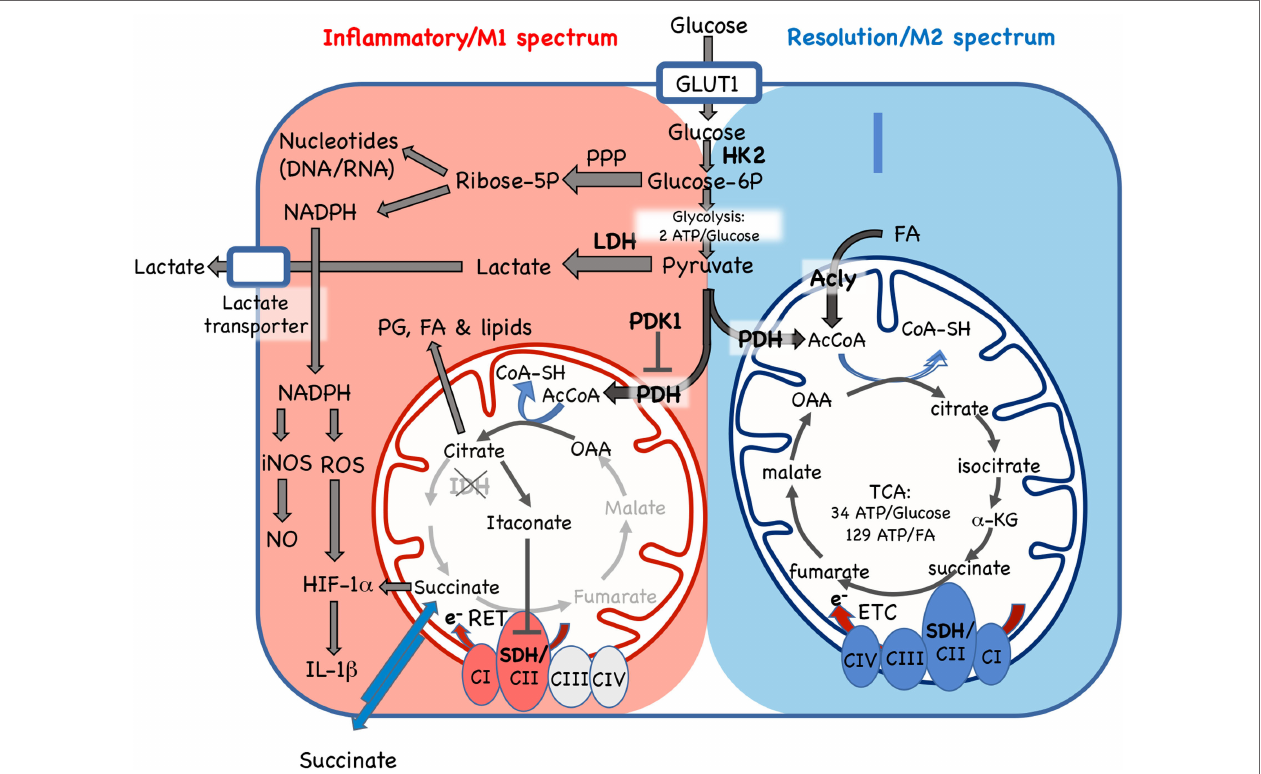
FiGURe 2 | Cellular metabolic pathways driving mononuclear phagocyte inflammatory vs. resolution phenotype. Glucose is essential for both inflammatory and resolution macrophage phenotypes. In inflammatory macrophages, glucose is largely processed to yield lactate via aerobic glycolysis. Another major pathway in M1 spectrum macrophages is conversion to ribose-5P via the pentose phosphate pathway (PPP) for synthesis of nucleotides and NADPH, which supports nitric oxide (NO), reactive oxygen species (ROS), and IL-1 β production. In resolution macrophages, the major fate of glucose is the TCA/Krebs cycle via pyruvate dehydrogenase (PDH)-catalyzed conversion of pyruvate to AcetylCoA (AcCoA). The TCA cycle in resolution macrophages is also fed by fatty acids (FA) via the ATP-citrate lyase (Acly) enzyme and promotes forward electron transport chain (ETC), from C1 to CIV, for ATP generation. In contrast, while some glucose enters the mitochondria in inflammatory macrophages, where it is converted to citrate, the TCA cycle is broken, with stops at the isocitrate dehydrogenase (IDH) and succinate dehydrogenase (SHD) steps. Citrate accumulation results in itaconate production, which inhibits SDH, and also promotes prostaglandin (PG), lipid and FA synthesis. In inflammatory macrophages, these blocks promote reverse electron transport chain (RET) from CII to CI. GLUT1, glucose transporter 1/SLC2A1; HK2, hexokinase 2; Glucose-6P, glucose-6-phosphate; LDH, lactose dehydrogenase; PHK1, pyruvate dehydrogenase kinase 1; AcCoa, acetyl coenzyme A; TCA, tricarboxylic acid/ Krebs cycle; a-KG, a-ketoglutarate; CI-IV, ETC complexes I–IV, SDH, succinate dehydrogenase; OAA, oxaloacetate; e - , electrons; RET, reverse electron transport chain; iNOS, inducible nitric oxide synthase; HIF-1 α , hypoxia inducible factor-1 α . Enzymes are indicated by bold